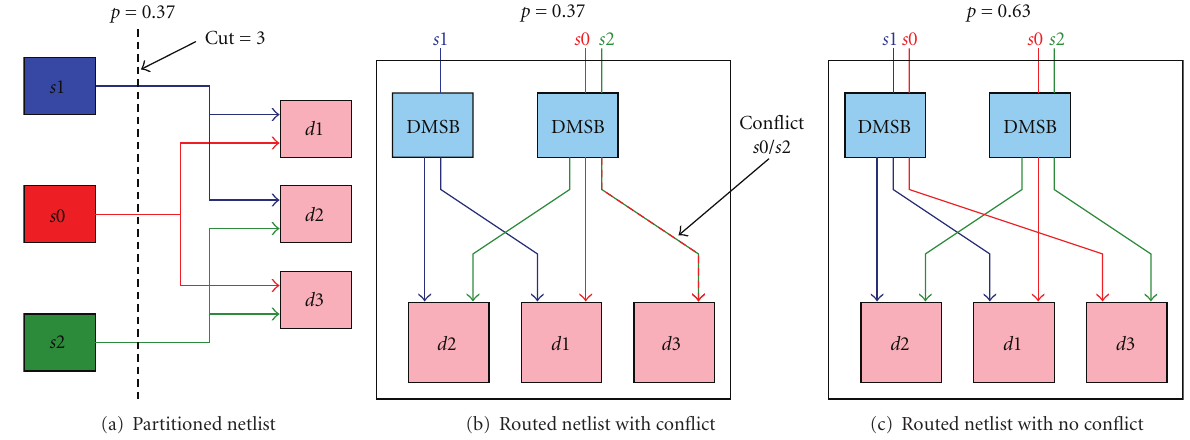
Figure 5: A netlist routing example showing architecture Rent’s parameter increase.